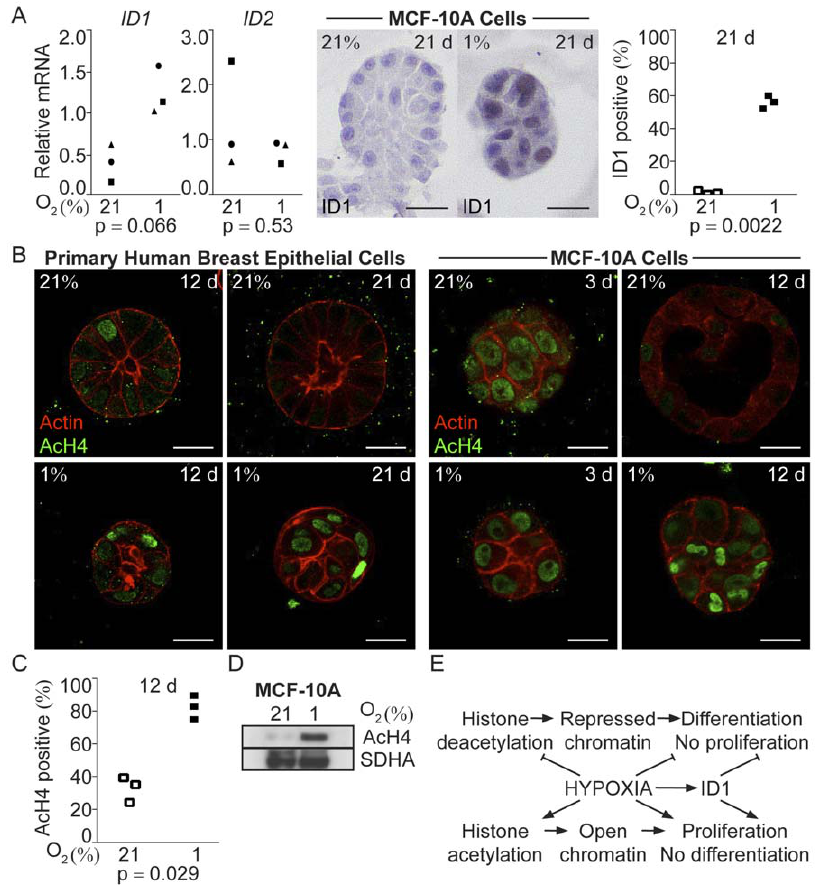
Figure 7. ID1 expression and histone acetylation in breast epithelial cells in normoxic compared to hypoxic 3D-cultures. A. Relative mRNA expression of the transcription modulating ID factors, ID1 and ID2 in MCF-10A cells after 21 days of 3D-culture on ECM-derived substrate under normoxic and hypoxic conditions (left). Showing data from three independent experiments. Statistical analysis was performed with Student’s paired t-test (p). Immunohistochemical staining for ID1 on paraffin-embedded MCF-10A acini-like structures after 21 days of 3D-culture at normoxia (21%) or hypoxia (1%) (right). Size bars 20 m m. B. Acetylated histone 4 (AcH4) visualized by immunofluorescence (green) in normoxic (21%) and hypoxic (1%) human primary breast epithelial cell (left) and MCF-10A cell (right) acini-like structures at the indicated days post seeding. Actin was visualized by phalloidin staining (red). Size bars 20 m m. C . Percentage of MCF-10A cells in acini-like structures with global histone acetylation, i.e. positive for AcH4, 21 days post-seeding at normoxia (open boxes) and hypoxia (black boxes), showing data from three independent experiments. At least 200 cells were calculated in each experiment. Statistical analysis was performed by Student’s paired t-test (p). D. Immunoblot of AcH4 in MCF-10A cells in 3D-culture at 21% (left) and 1% (right) on ECM-derived substrate for 10 days. SDHA was used as a loading control. E. Non-malignant breast epithelial cells grown on differentiation-inducing ECM have an organized cell shape and a high degree of deacetylated histones; these cells differentiate and become post- mitotic. Contrary, breast epithelial cells grown as monolayer without ECM do not receive/accept signals to induce differentiation, leading to sustained global histone acetylation and opening of the chromatin for transcription, resulting in impaired differentiation and/or dedifferentiation accompanied with cell proliferation. Hypoxia, including hypoxic induction of ID1, promotes a proliferative and undifferentiated state in breast epithelial cells despite contact with the ECM.